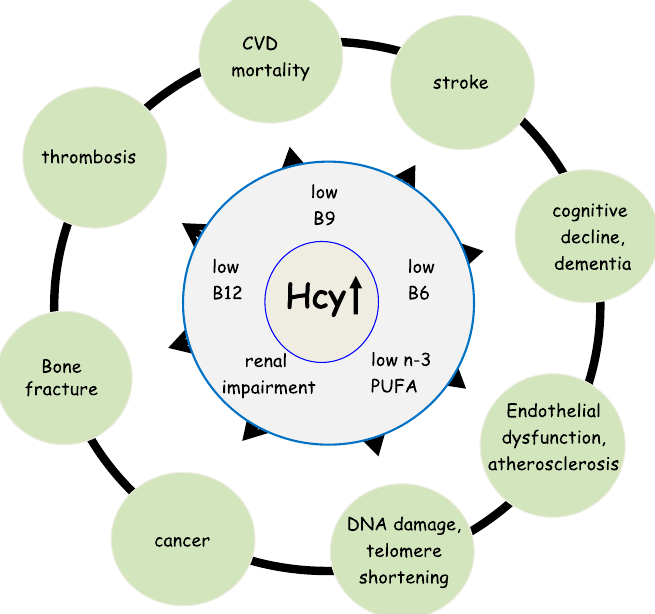
Figure 1. Hyperhomocysteinemia, B vitamins deficiency and age-related diseases. Hcy, homocysteine; PUFA, polyunsaturated fatty acids; ↑ increase.